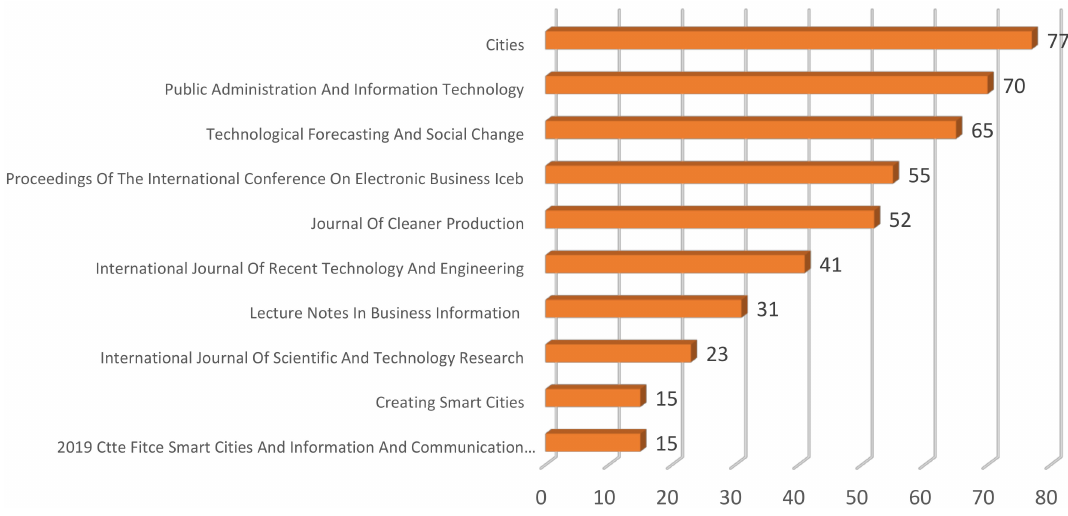
Figure 4. The list of the most productive sources (minimum 10 documents for the adopted period). The highest score was reached by cities (17%), followed by public administration and information technology (16%), and technologically forecasting and social change